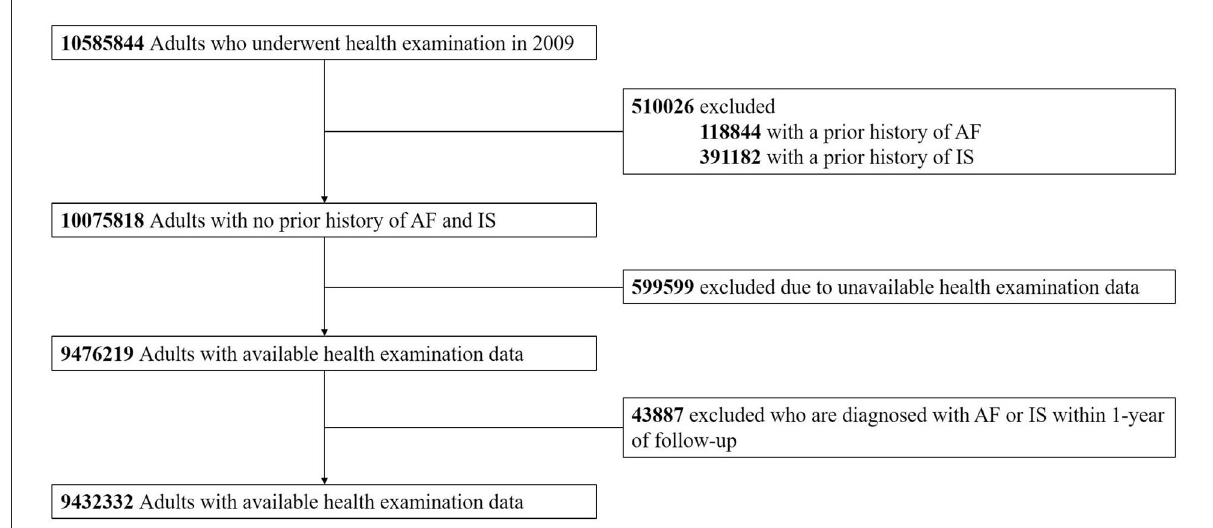
FIGURE1 Study enrolment flow. AF, atrial fibrillation; IS, ischaemic